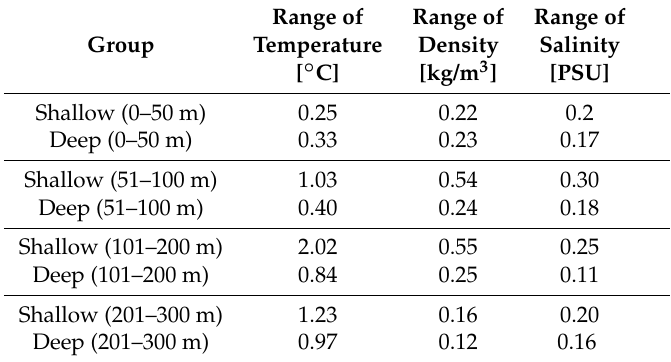
Table 2. Ranges of temperature, density, and salinity for shallow and deep stations averaged by depth intervals. Range of Range of Range of Group Temperature